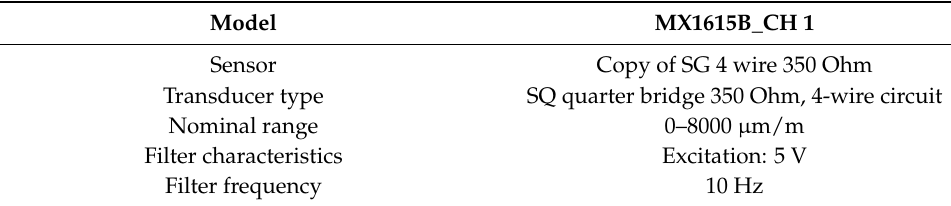
Figure 20. Data acquisition system. Table 10. Specification of strain gauge and data acquisition system.